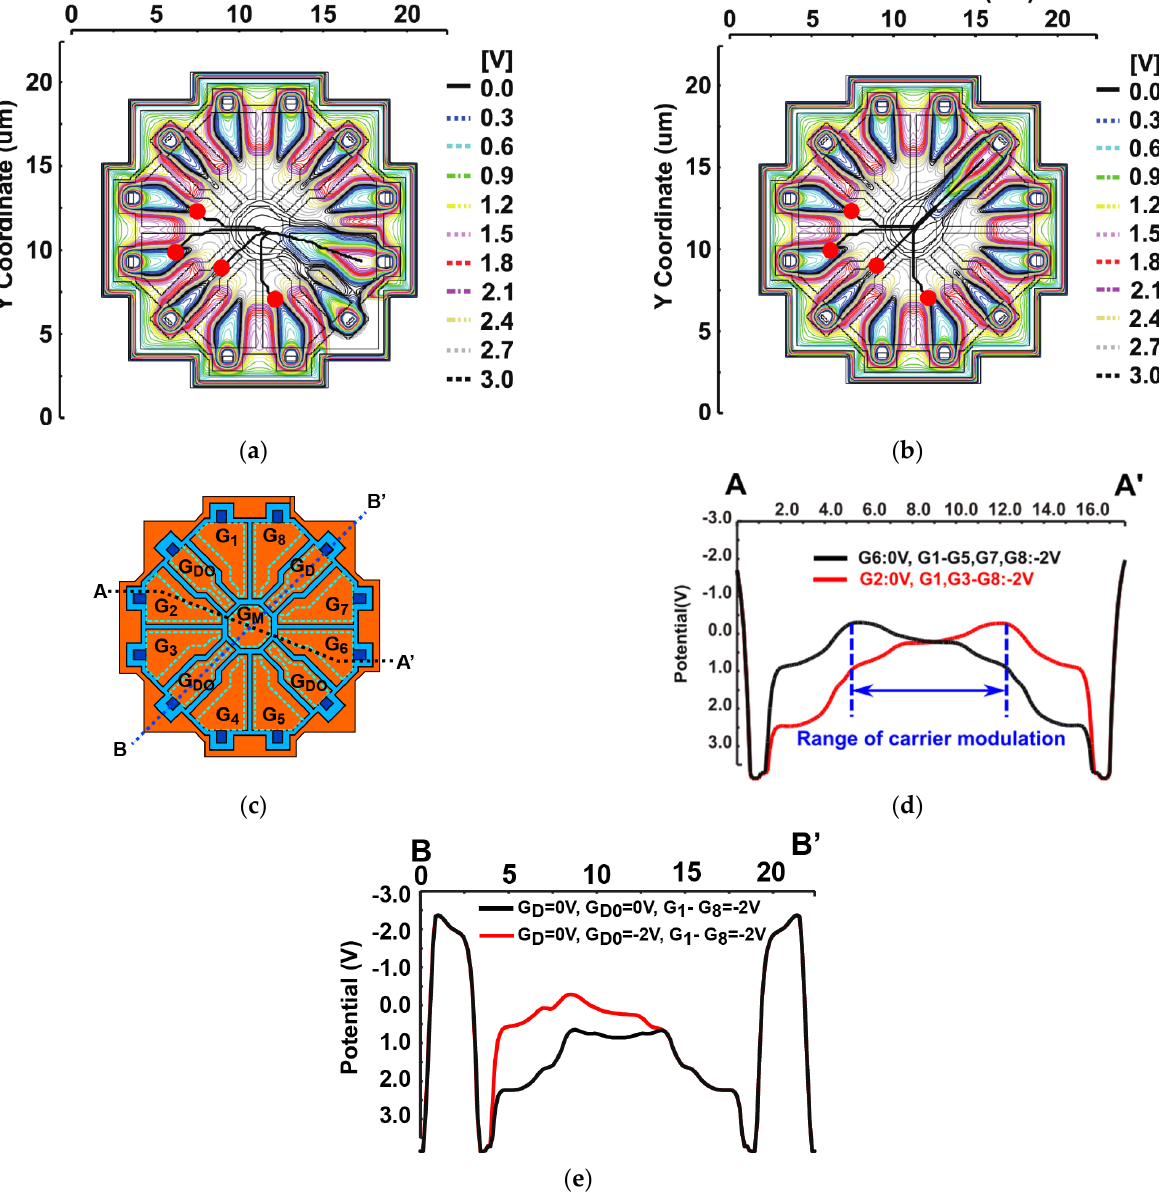
Figure 3. 3D device simulation results of the 8-tap PND: ( a ) X-Y 2D potential plot and carrier traces to transfer to G 6 ; ( b ) X-Y 2D potential plot and carrier traces to transfer to G D ; ( c ) demodulator top view; ( d ) 1D potential plot (A–A’) for carrier transfer to floating diffusions, FD 6 and FD 2 ; ( e ) 1D potential plot (B–B’) for carrier transferring to a drain through G D only (red line) and that for carrier transferring to a drain through G D and G DO (black line).